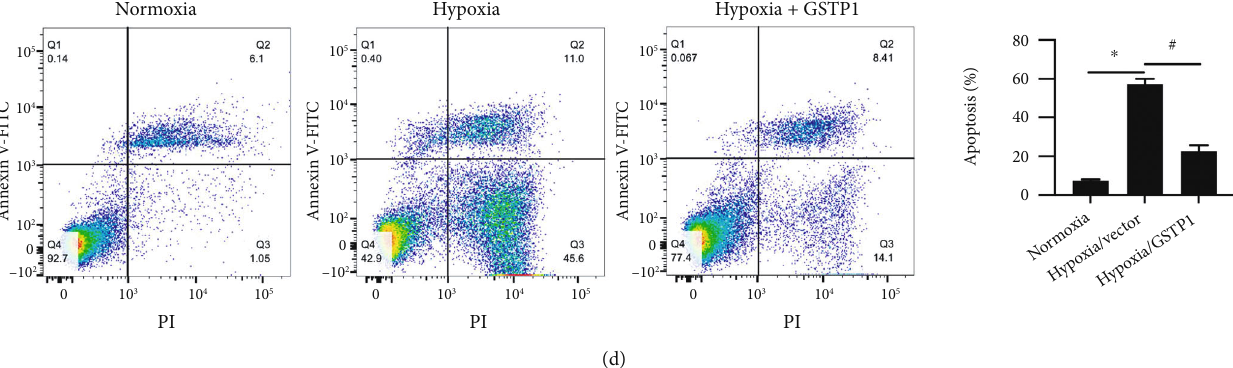
Figure 5: Overexpressed GSTP1 exerts protective e ff ects against hypoxia-induced cell injury. (a) After being cultured under normoxia or hypoxia condition for 24 hours, cell viability was measured by performing CCK-8 assay. * P < 0 : 05 , vs. normoxia group; # P < 0 : 05 , vs. hypoxia/vector group. After being cultured under normoxia or hypoxia condition for 24 hours, cell migration (b) and invasion (c) were detected, respectively. (d) After being cultured under normoxia or hypoxia condition for 48 hours, cells were collected and stained using Annexin V-FITC/PI double staining, then stained cells were analyzed by performing fl ow cytometry assay. * P < 0 : 05 , vs. normoxia group; # P < 0 : 05 , vs. hypoxia/vector group.